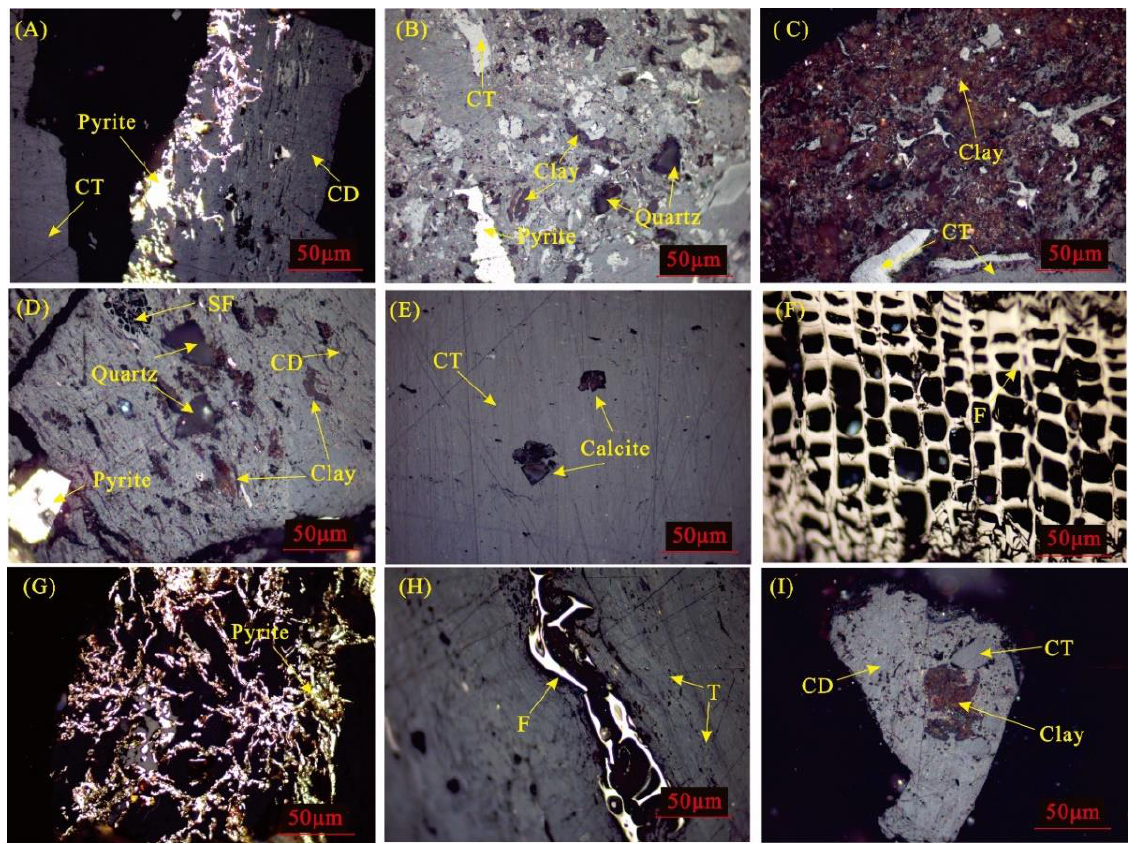
Figure 3. Coal petrology characteristics in No. 26 coal. ( A ) Collotelinite, collodetrinite, and pyrite in sample JD-26-01; ( B ) Collotelinite, clay, quartz, and pyrite in sample JD-26-01; ( C ) Collotelinite and clays in sample JD-26-04; ( D ) Collodetrinite, semifusinite, quartz, pyrite and clay minerals in sample JD-26-04; ( E ) Collotelinite and calcite in sample JD-26-05; ( F ) Fusinite in sample JD-26-07; ( G ) Pyrite in in sample JD-26-07; ( H ) Telinite and Fusinite in sample JD-26-07; ( I ) Collodetrinite, collotelinite and clays in sample JD-26-08. T — telinite; CT — collotelinite; CD — collodetrinite; F — fusinite; SF — semifusinite. Table 2. Coal petrology characteristics of No. 26 coals (Vol.%).